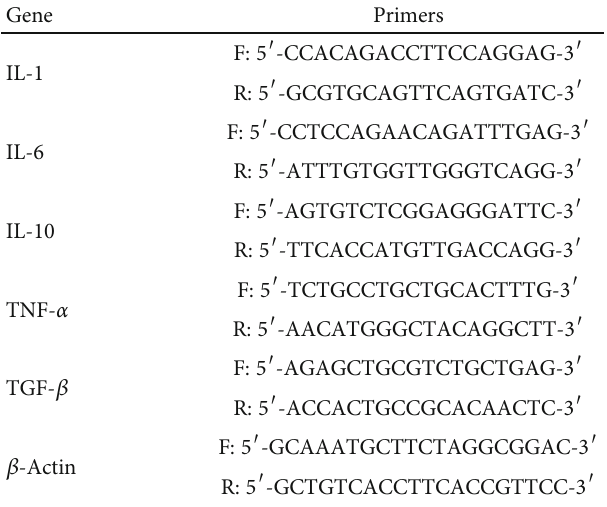
Table 1: The primers used in this study.